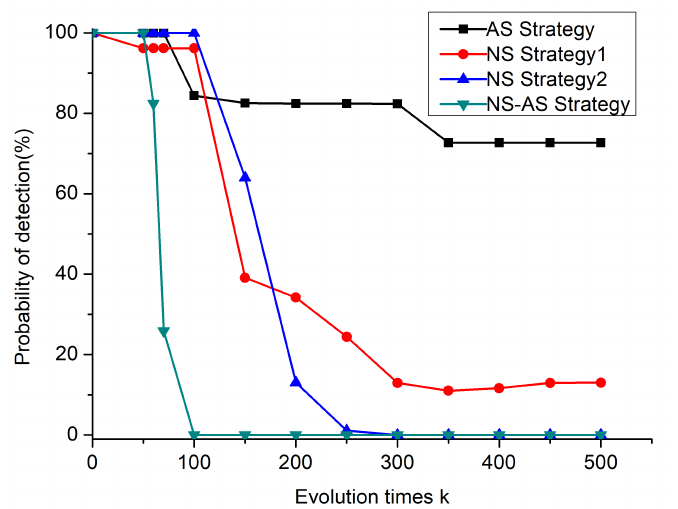
Figure 11. The influence of different evolution strategies on the radar detection probability.